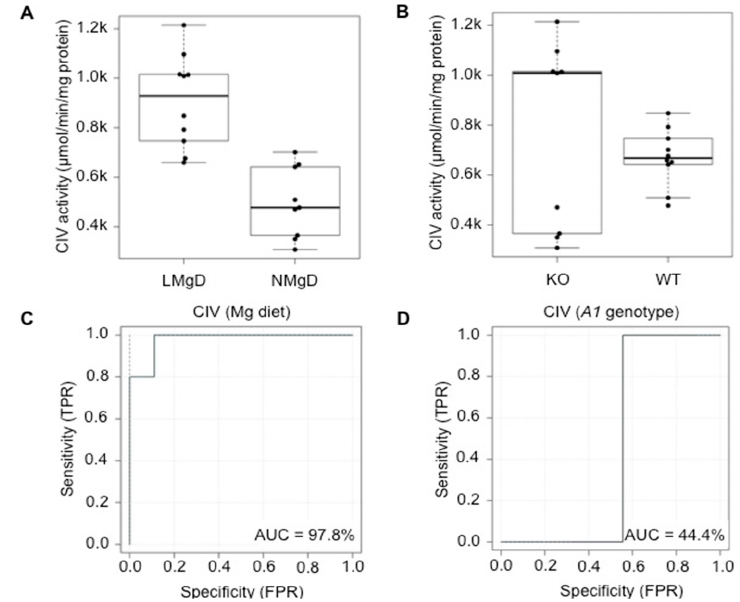
Figure 7. Impact of dietary Mg content and Slc41a1 genotype on the activity of complex IV (CIV) in murine cardiac mitochondria. ( A ) Box-and-whisker plot overlaid with dot plot showing the influence of dietary Mg content (LMgD vs. NMgD) and ( B ) Slc41a1 genotype ( Slc41a1 − / − vs. Slc41a1 +/+ ) on CIV activity in murine mitochondria. For both, A and B, the original source data and corresponding medians are indicated for each group. The interaction of data is presented in Figure A1. ( C , D ) Empirical ROC (receiver operating characteristic) curves with the area under the ROC curve (AUC) for ( C ) the type of Mg diet as predictor of CIV activity and ( D ) the Slc41a1 genotype as predictor of CIV activity. Abbreviations: A1 , Slc41a1 ; FPR, false-positive rate; KO, knock-out; TPR, true-positive rate; WT, wild-type. Int. J. Mol. Sci. 2020 , 21 , x FOR PEER REVIEW 10 of 25